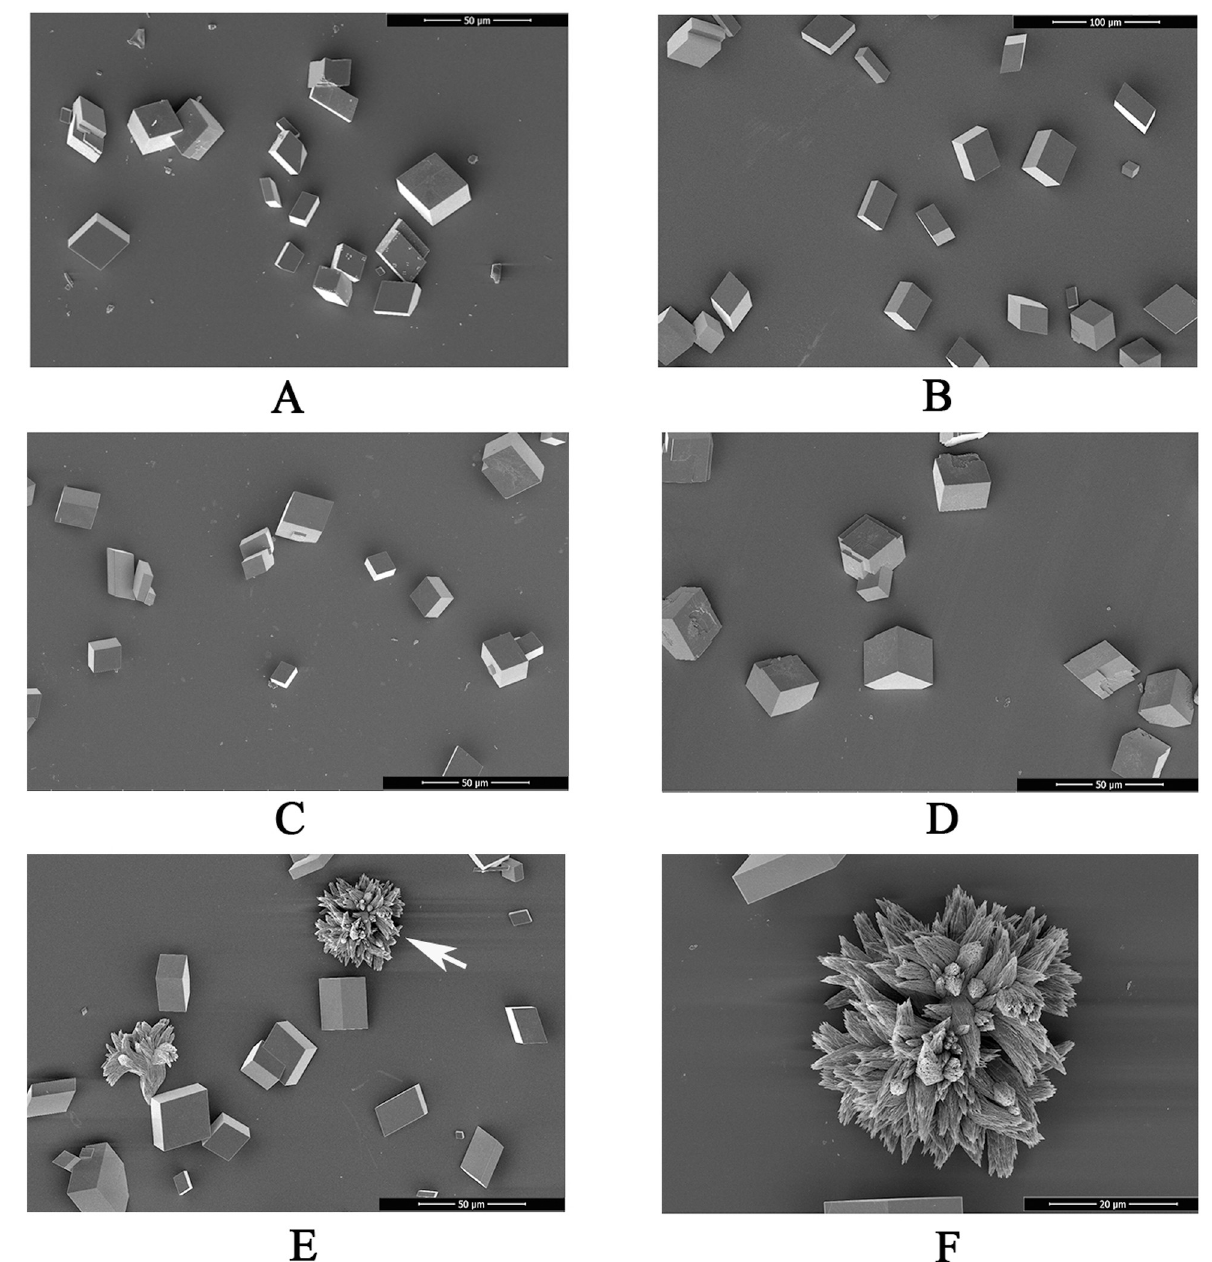
Fig 5. SEM images of in vitro calcite crystallization in the presence of rWLP at increasing concentrations. A: calcite crystals grown without protein induction. B: calcite crystals grown with 50 μ g/mL BSA. C: calcite crystals grown with 10 μ g/mL rWLP. D: calcite crystals grown with 30 μ g/ mL rWLP. E: crystals grown with 50 μ g/mL rWLP. F: enlarged image of E.